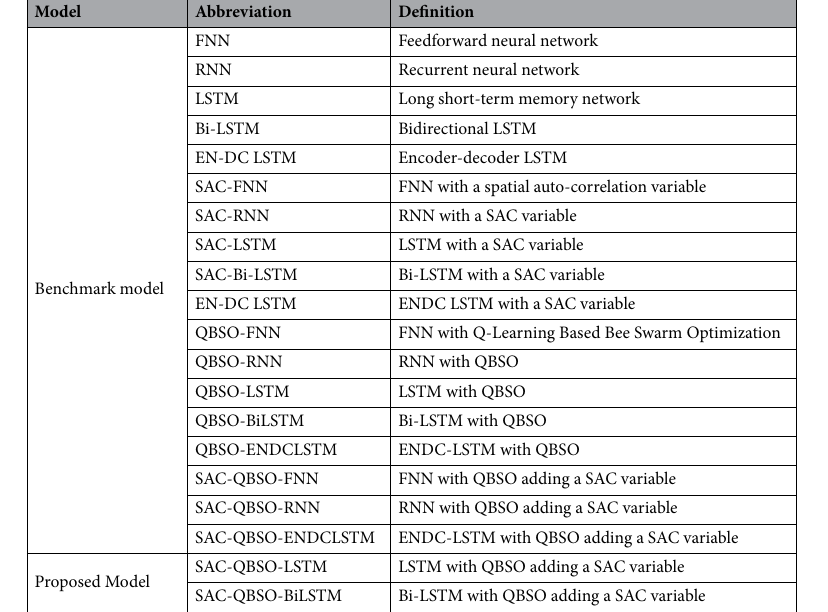
Table 3. The models compared and their